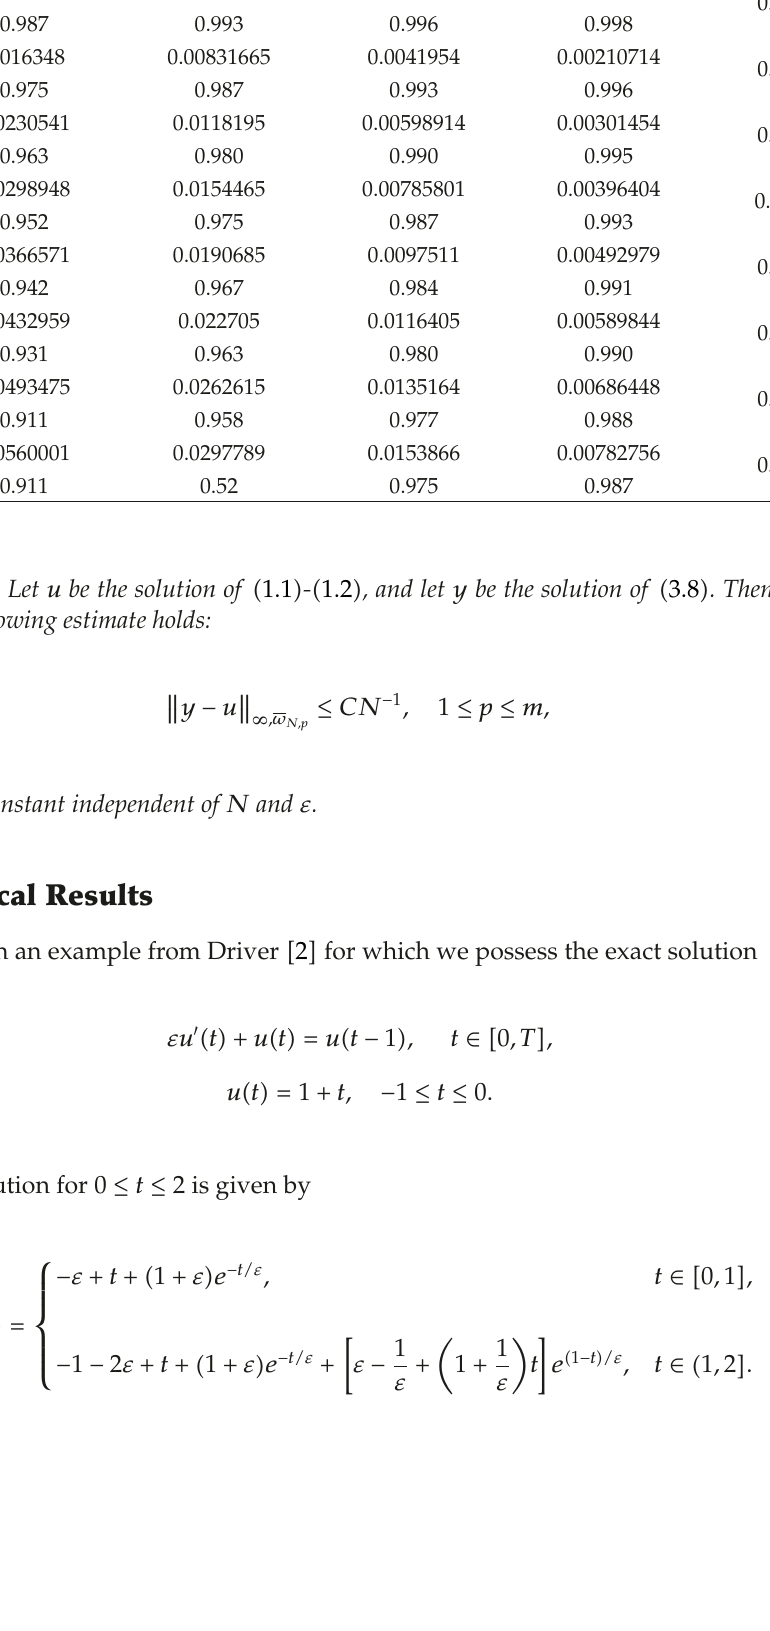
Table 1: Maximum Errors and Rates of Convergence for the Bakhvalov-Shishkin Mesh on ω